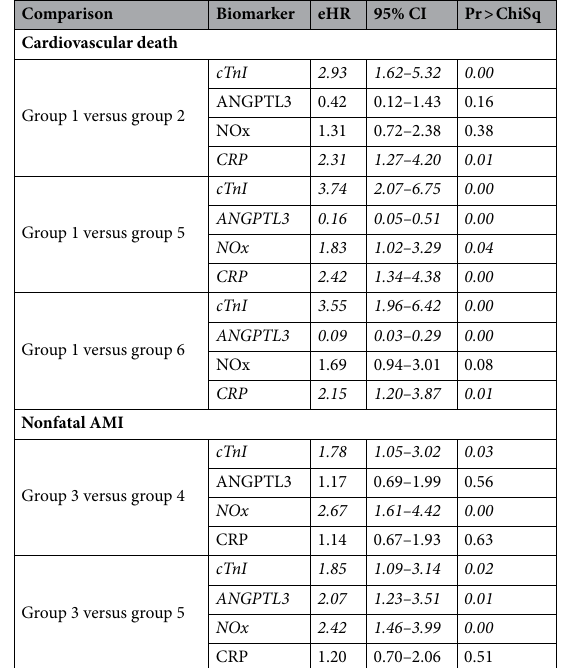
Table 5. Multivariate Cox regression analysis for associations of top 6 biomarkers with cardiovascular death and nonfatal AMI adjusted for sex and age. Significant values are in [italics]. ANGPTL3, angiopoietin-like protein 3; NOx, nitrate and nitrite; cTnI, cardiac troponin I; CRP, C-reactive protein; eHR, estimated hazard